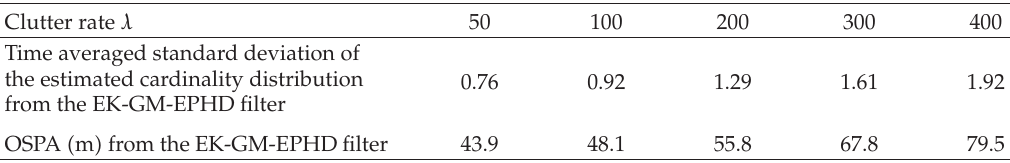
Table 3: Time averaged standard deviation of the estimated cardinality distribution and time averaged OSPA (cid:2) m (cid:3) from the EK-GM-EPHD filter in various J given λ (cid:8) 50. Gaussian number J in the mixture 50 100 300 500 700 Time averaged standard deviation of the estimated cardinality distribution 3.15 2.29 1.77 1.21 0.76 from the EK-GM-EPHD filter 93.2 86.7 75.3 54.6 43.9 Table 4: Time averaged standard deviation of the estimated cardinality distribution and time averaged OSPA (cid:2) m (cid:3) from the EK-GM-EPHD filter in various λ given J (cid:8) 700. Clutter rate λ 50 100 200 300 400 Time averaged standard deviation of the estimated cardinality distribution 0.76 0.92 1.29 1.61 from the EK-GM-EPHD filter